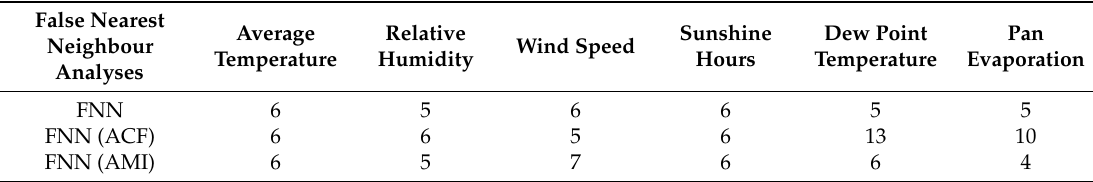
Table 4. Results from the false nearest neighbour